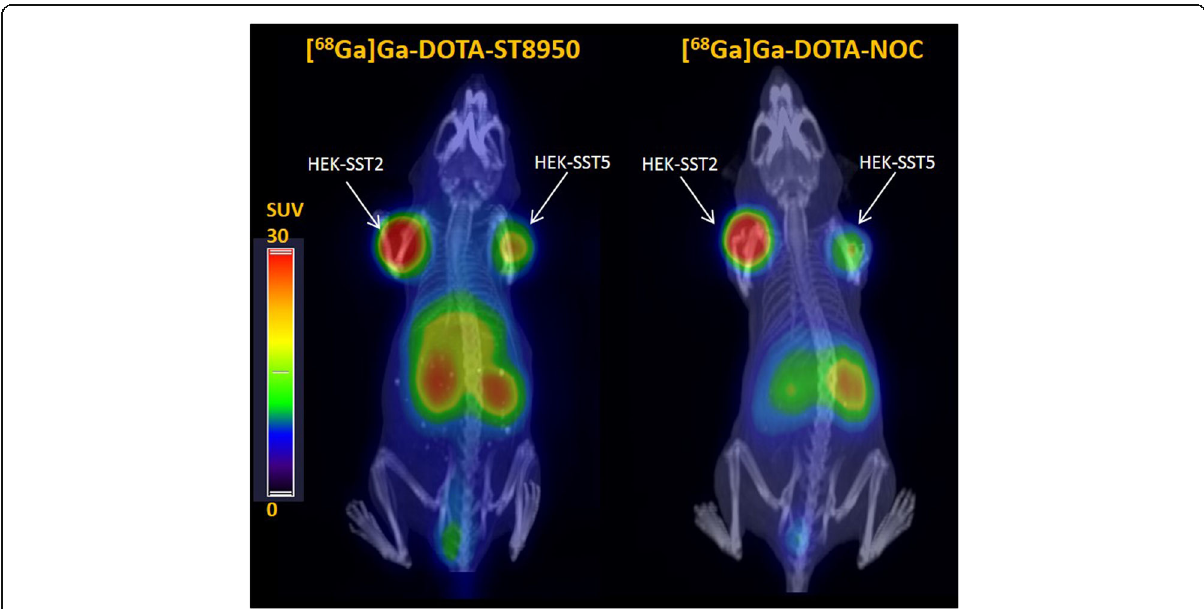
Fig. 4 Maximum intensity projection (MIP) PET/CT images of [ 68 Ga]Ga-DOTA-ST8950 and [ 68 Ga]Ga-DOTA-NOC (100 μ L/100 pmol/5 MBq, apparent molar activity of 50 MBq/nmol) in a dual SST2- and SST5-expressing tumor mouse model, 1 h after the injection of the radiotracer (SUV: standard uptake